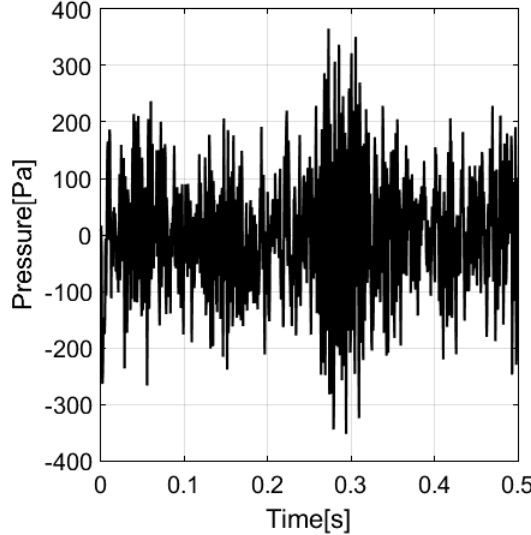
Figure 7. CFD time